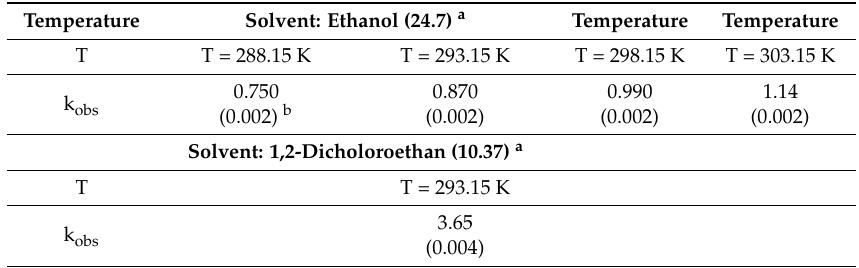
Table 2. The values of k obs (min − 1 ) for the reaction between TPP (5.00 × 10 − 3 M), DMAD (5.00 × 10 − 3 M) and MA (5.00 × 10 − 3 M) in different solvent media and